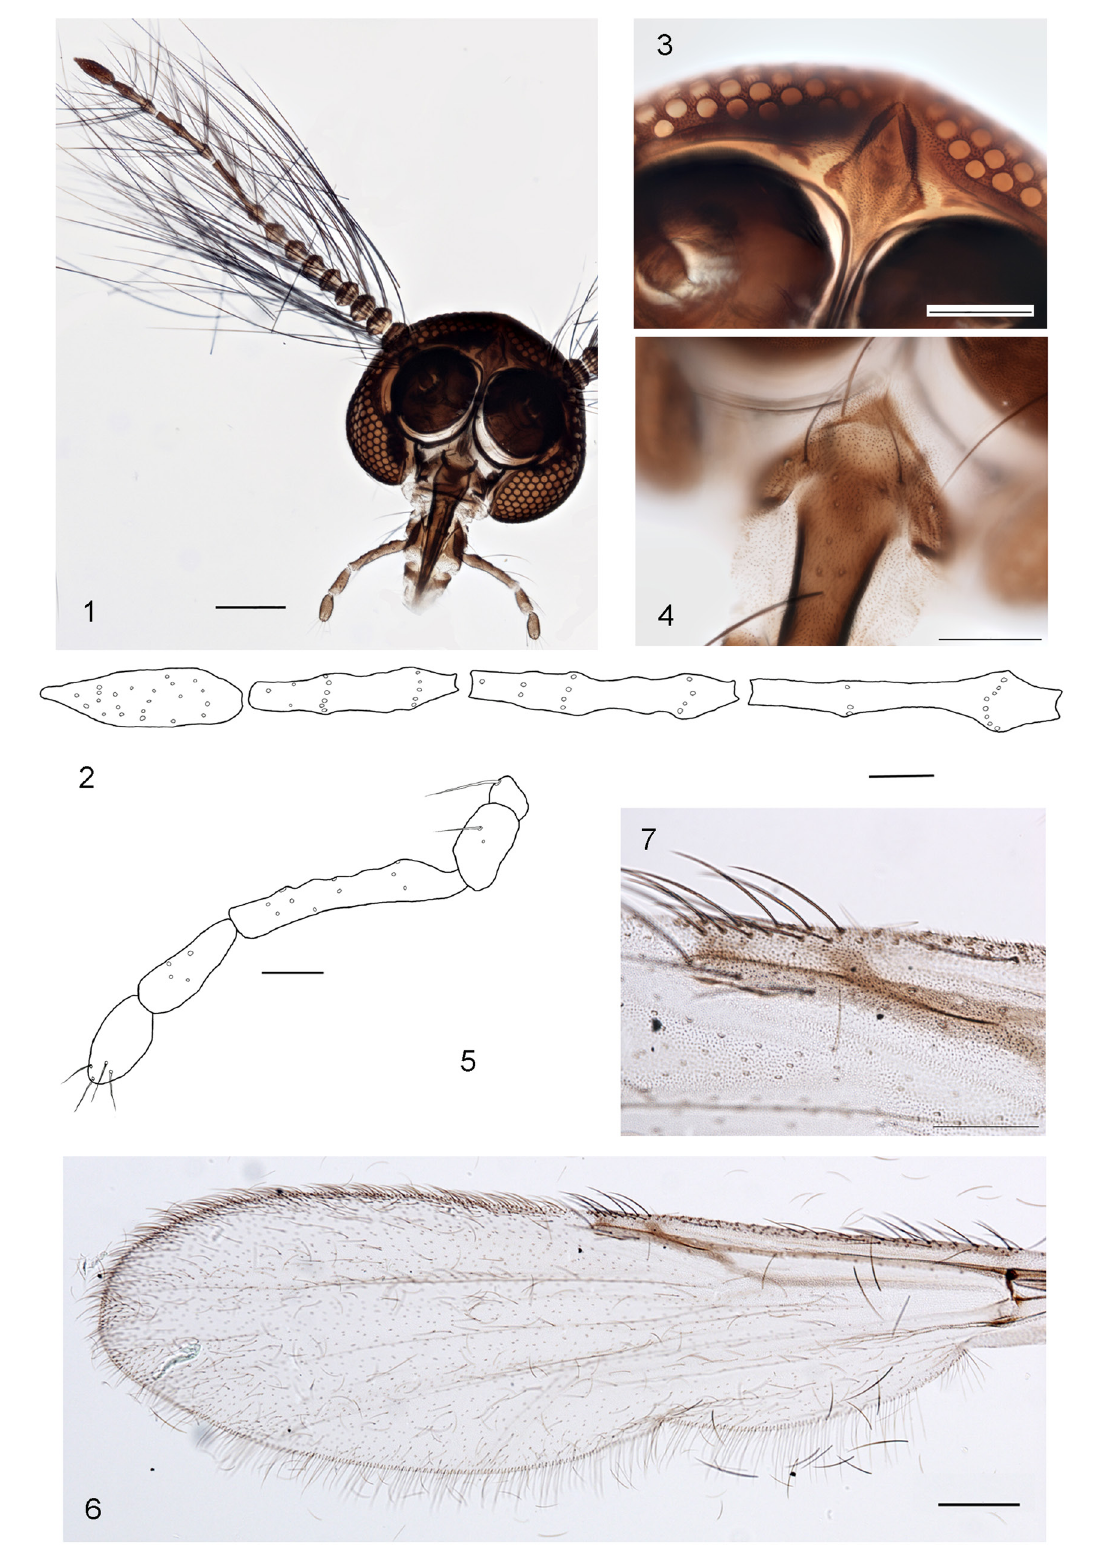
Figs 1–7. Dasyhelea dominiakae sp. nov., holotype, ♂. 1 . Head. 2 . Distal flagellomeres. 3 . Frontal sclerite. 4 . Clypeus. 5 . Palp. 6 . Wing. 7 . First and second radial cell of wing. Scale bars: 1, 6 = 100 µm; 3–4, 7 = 50 µm; 2, 5 = 25